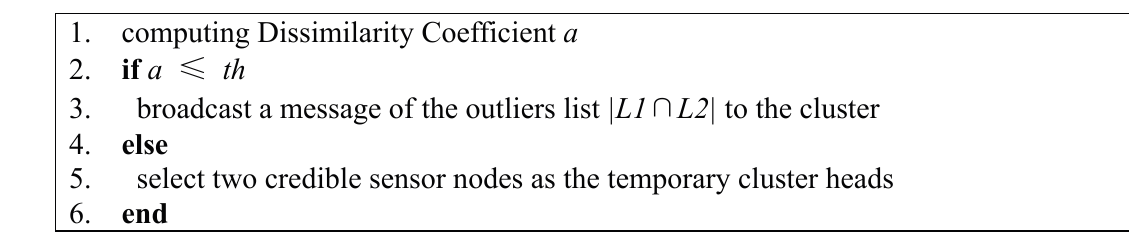
Figure 8. The procedure performed by the base